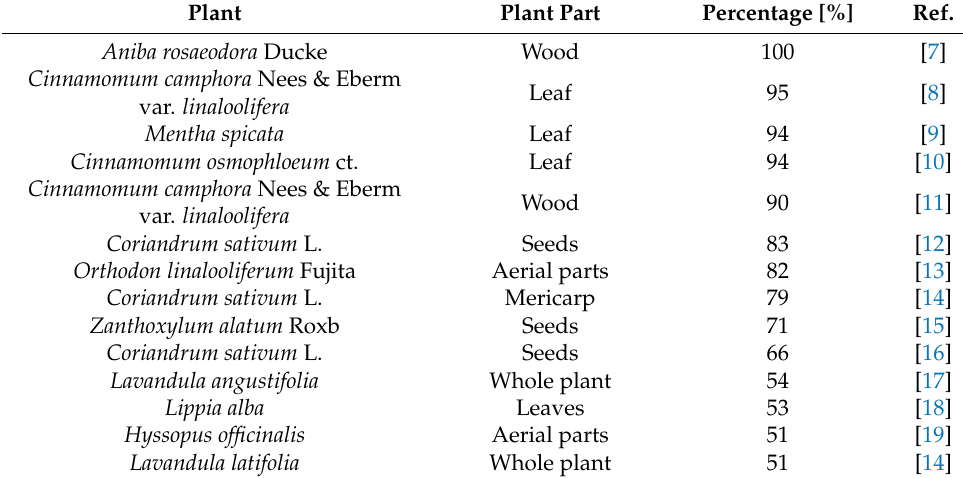
Table 1. Plant resources of linalool. Plant Plant Part Percentage [%] Ref.